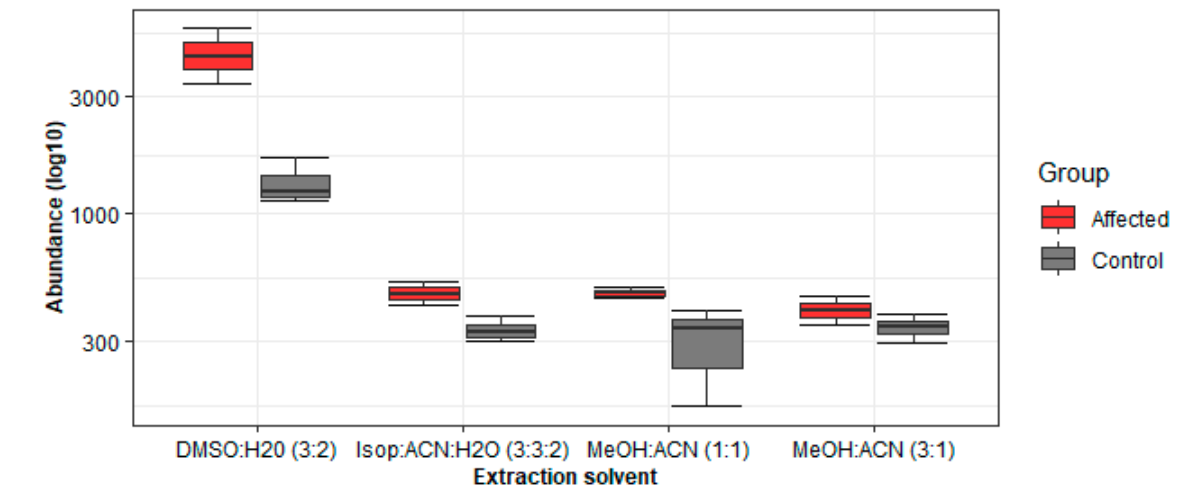
Figure 7. Heatmap showing the reproducibility of the extraction procedure.